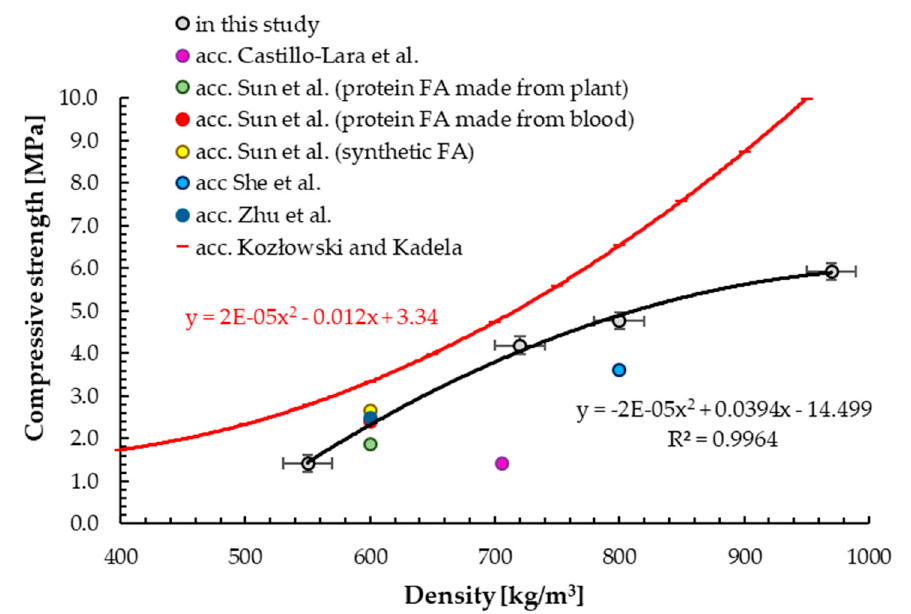
Figure 7. Relationship between density and compressive strength of hardened foamed concrete.